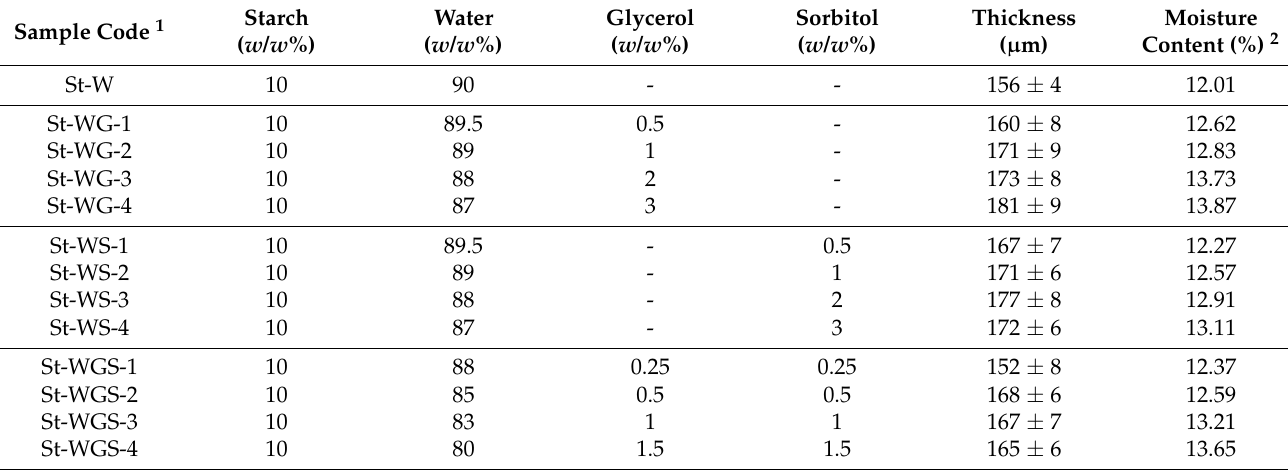
Table 1. Formulations, sample codes, and the film